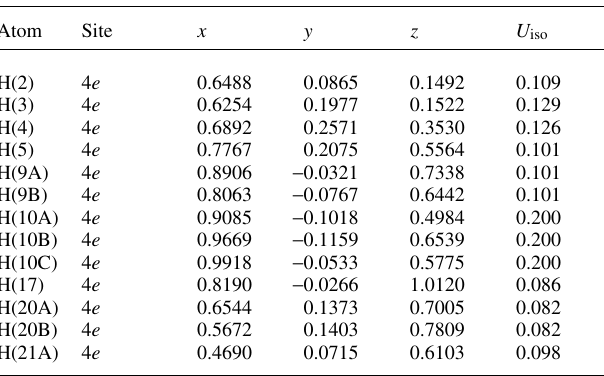
Table 2. Atomic coordinates and displacement parameters (in Å 2 )